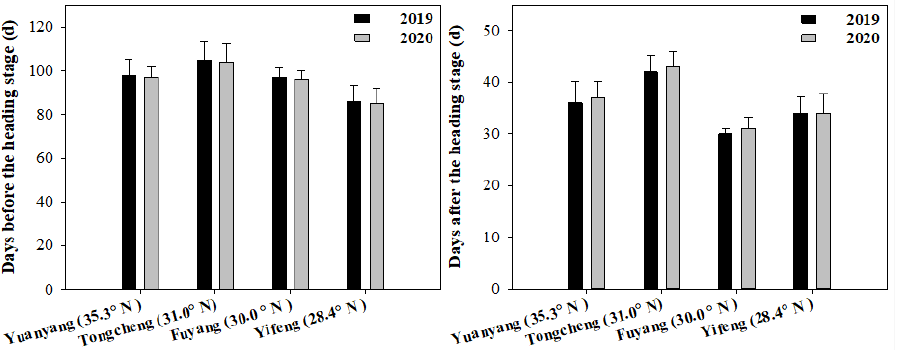
Figure 1. The rice growth duration before the heading and after heading stages in different areas in 2019 and 2020.Vertical bars represent ± standard error of the means of six cultivars ( n = 6). 2.3. The Difference of Grain Yield and Yield Components across Four Areas and Two Years In 2019, the average yield of the six cultivars was the lowest in Yifeng (28.4 ◦ N), with 52.3%, 28.6% and 31.7% lower in Yuangyang (35.3 ◦ N), Fuyang (30.0 ◦ N) and Tongcheng (31.0 ◦ N), respectively (Figure 2). In 2020, the results showed that the yield in Yifeng (28.4 ◦ N) was 1.2%, 18.5% and 28.4% lower in Yuangyang (35.3 ◦ N), Fuyang (30.0 ◦ N) and Tongcheng (31.0 ◦ N), respectively. In addition, the yield in each area in 2020 was higher than the yield in 2019, except in Yuangyang (35.3 ◦ N). Although this tendency was not always significant in some cultivars, the overall tendencies of the yields of the six cultivars were identical across the different areas each year.